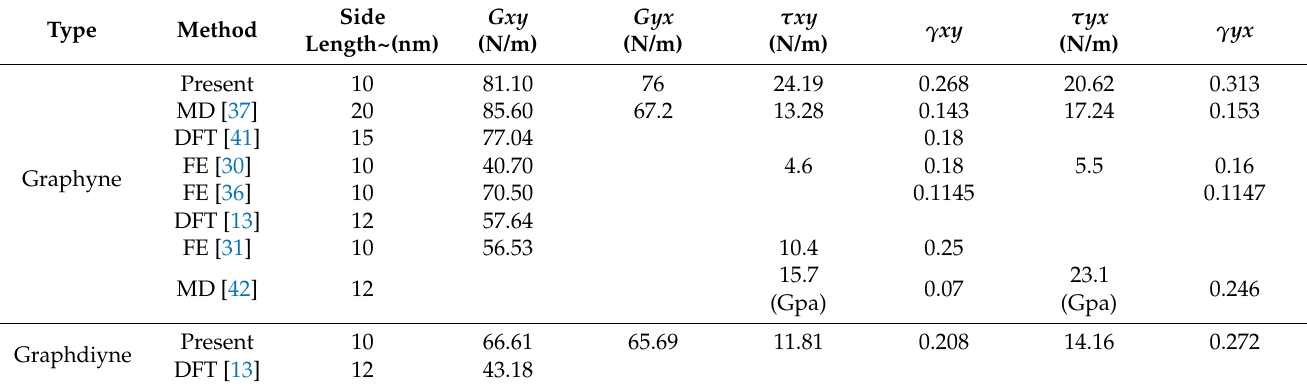
Table 2. Some comparisons between the present numerical outcome and other corresponding